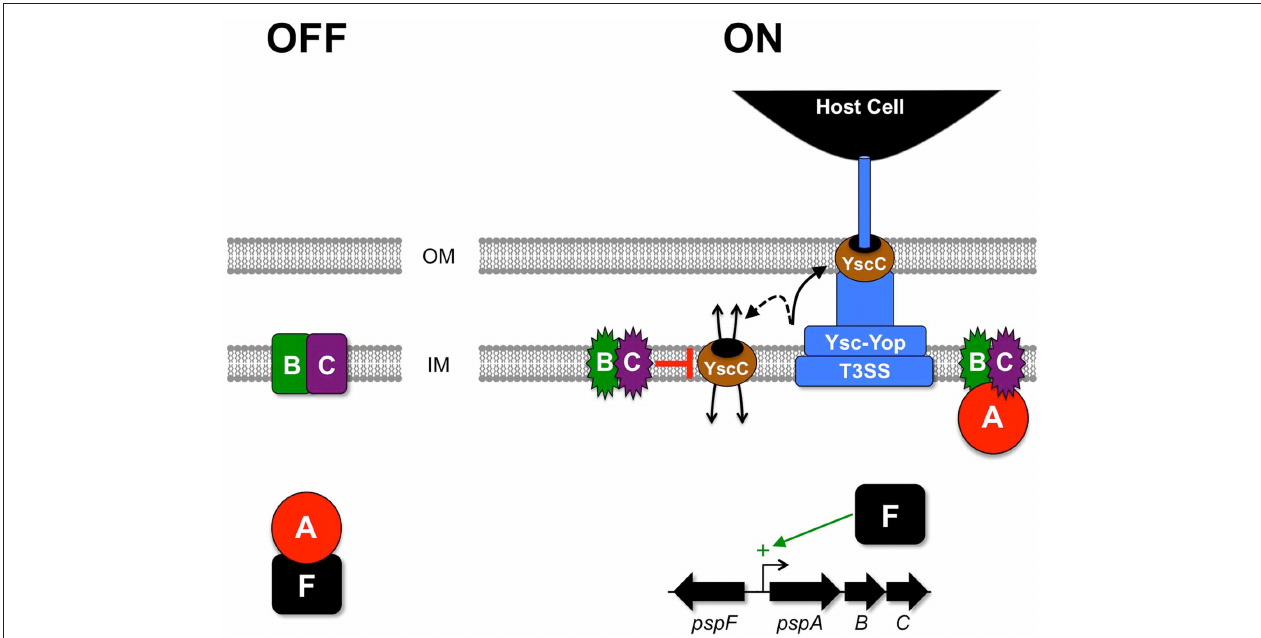
FIGURE 3 | Activation of the Psp ESR and relief of YscC-induced stress in Y. enterocolitica . In the absence of Ysc-Yop T3SS production, PspA binds to the transcription factor PspF in the cytoplasm and inhibits it. When the Ysc-Yop apparatus is produced some of its secretin component (YscC) mislocalizes into the cytoplasmic membrane. This event is sensed by the